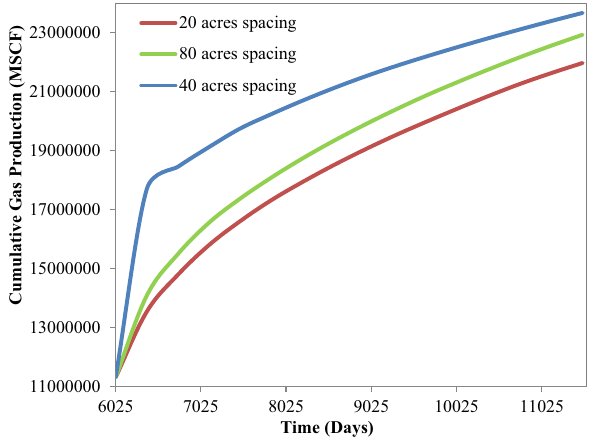
Fig. 19 Cumulative gas production versus time for 4 vertical infill wells at different well spacings